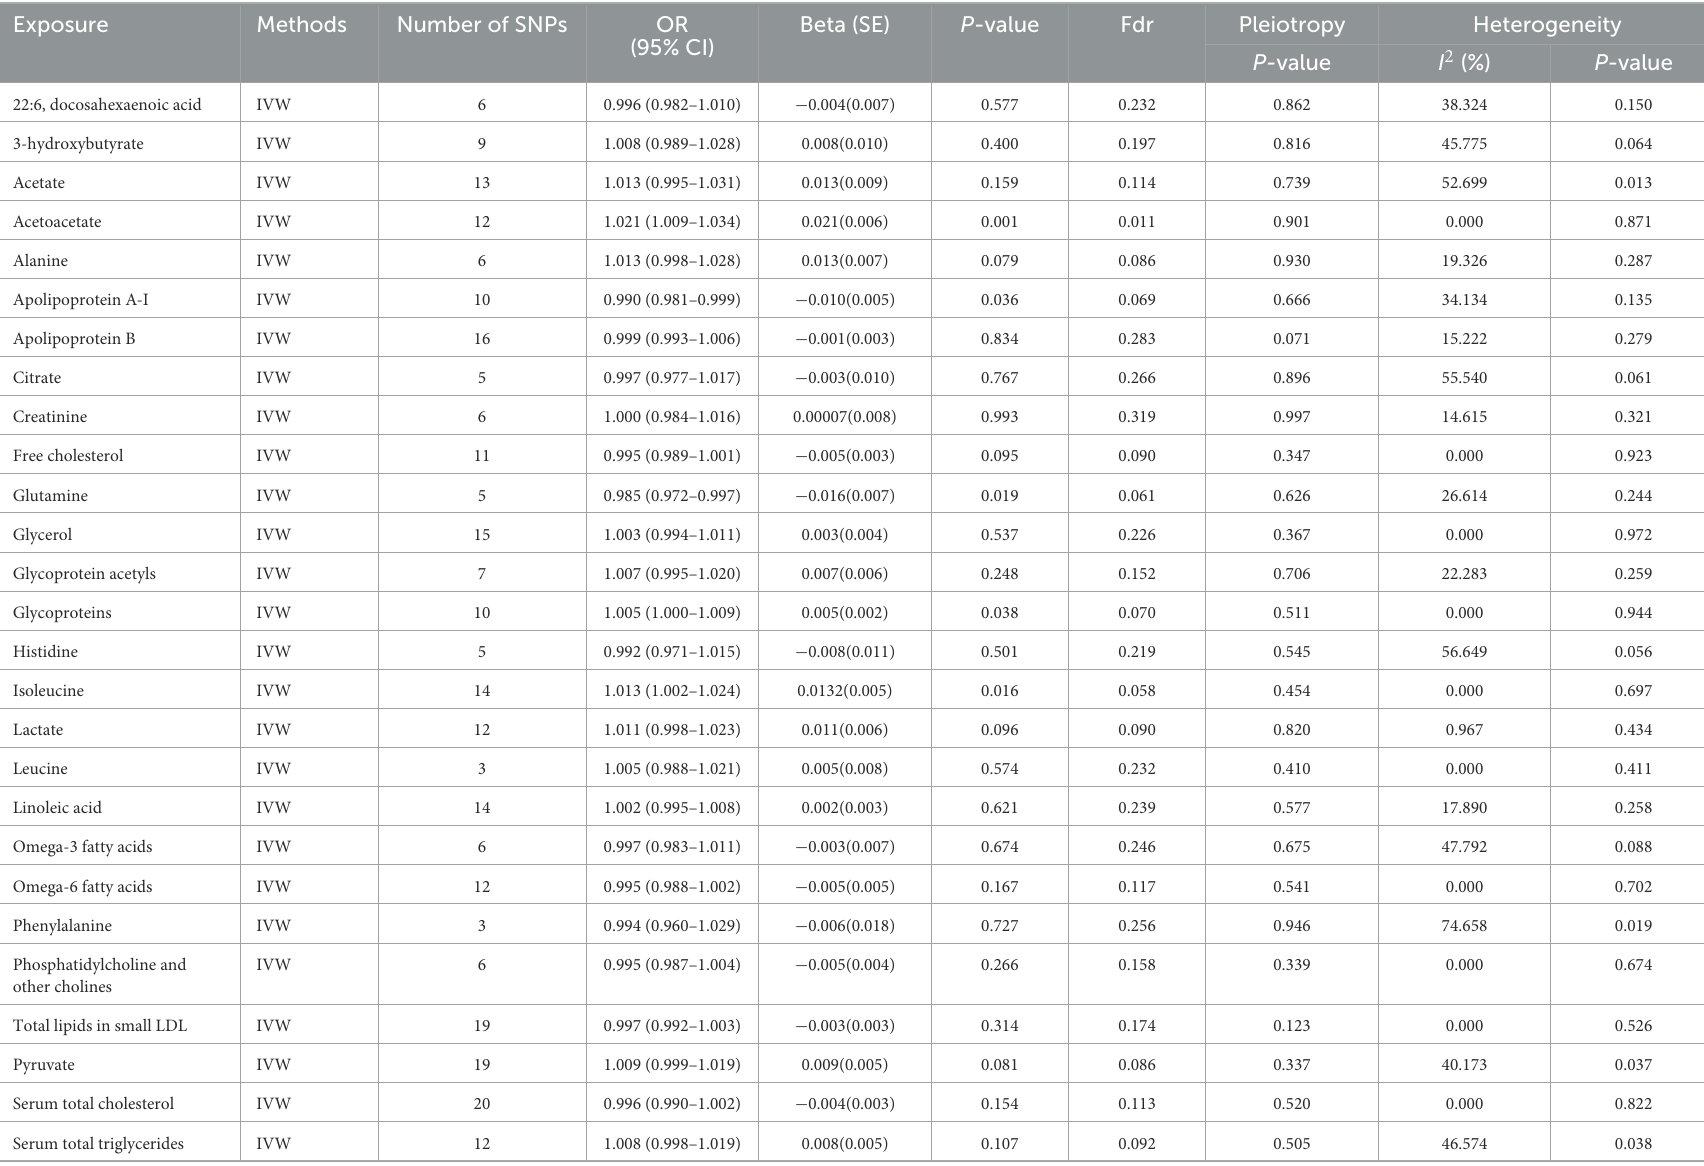
TABLE 1 Features of the included study